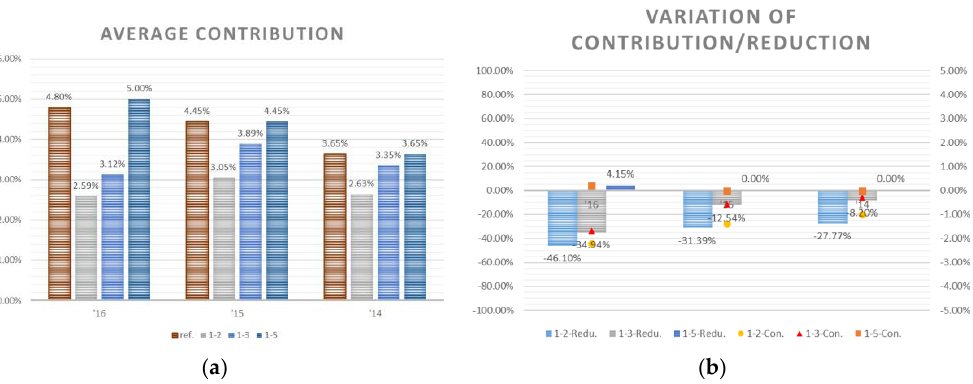
Figure 4. Sensitivity simulation results of sustained response period constraint: ( a ) Average contribution; ( b ) Variation of contribution and reduction.